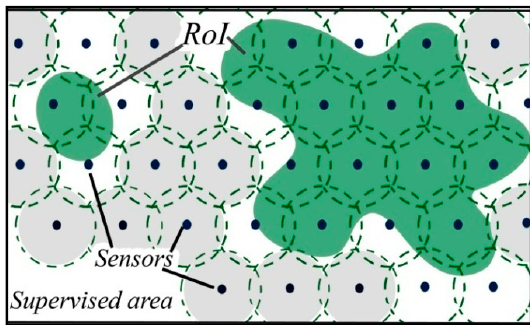
Figure 7. Triangular grid deployment.